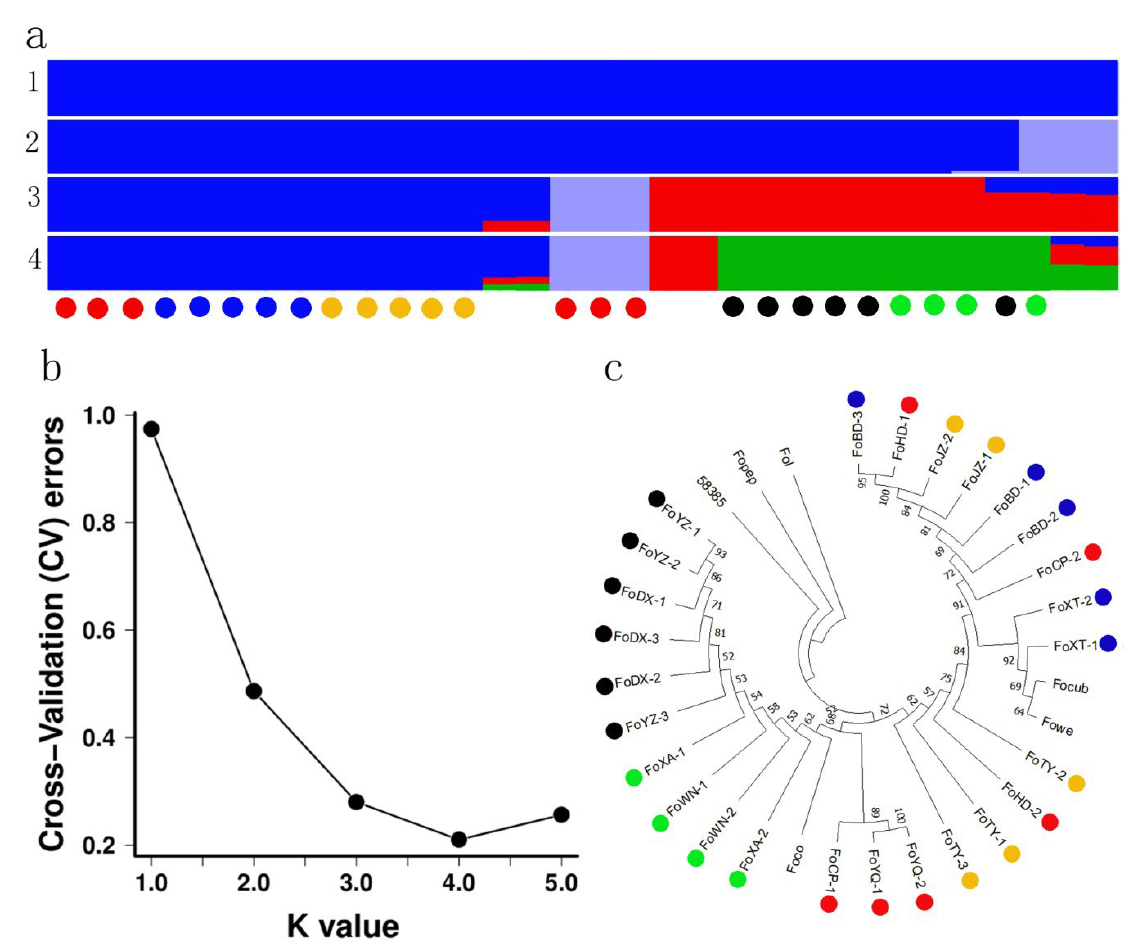
Figure 4. Population structure of FOC1 in northern China. Red, blue, yellow, black, and green circles represent the FOC1 isolates collected from Beijing, Hebei, Shanxi, Gansu, and Shaanxi Provinces, respectively. ( a ) Population structure of 26 FOC1 isolates and other six FO using the admixture software. K is the delta K value for population structure; ( b ) delta K value estimation of sequenced FO; ( c ) neighbor-joining phylogenetic tree constructed by SNP of the 26 FOC1 isolates and the other 6 FO.